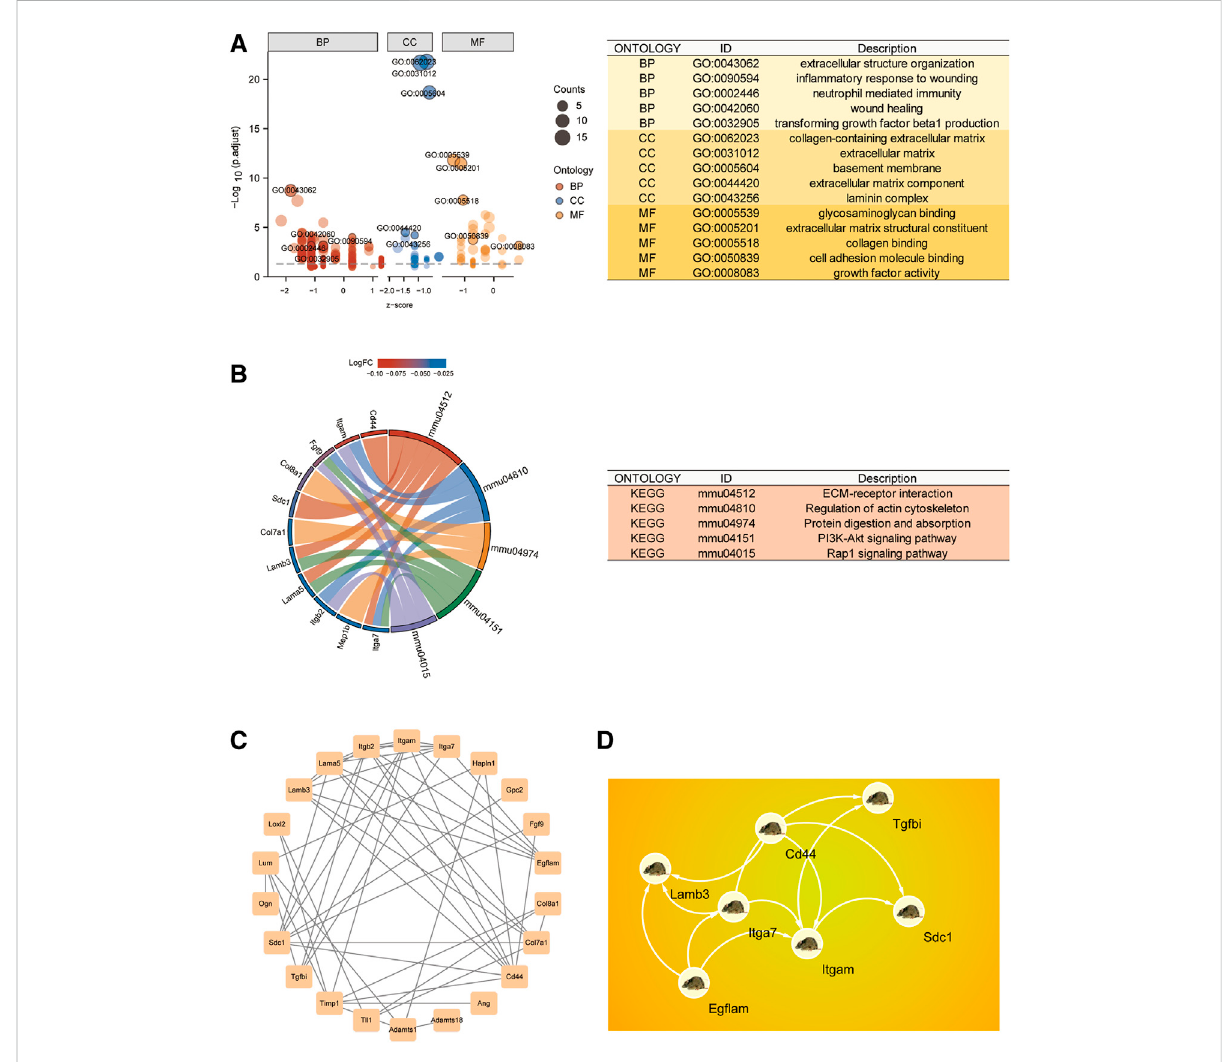
FIGURE 2 CGfunctional enrichmentanalyses(FEA)and hubgeneidenti fi cation. (A) GOFEA ofCGs. (B) KEGGnetworkanalyses ofCGs. (C) PPI network of CGs generated using the STRING database. (D) The leading 7 hub genes, as screened by